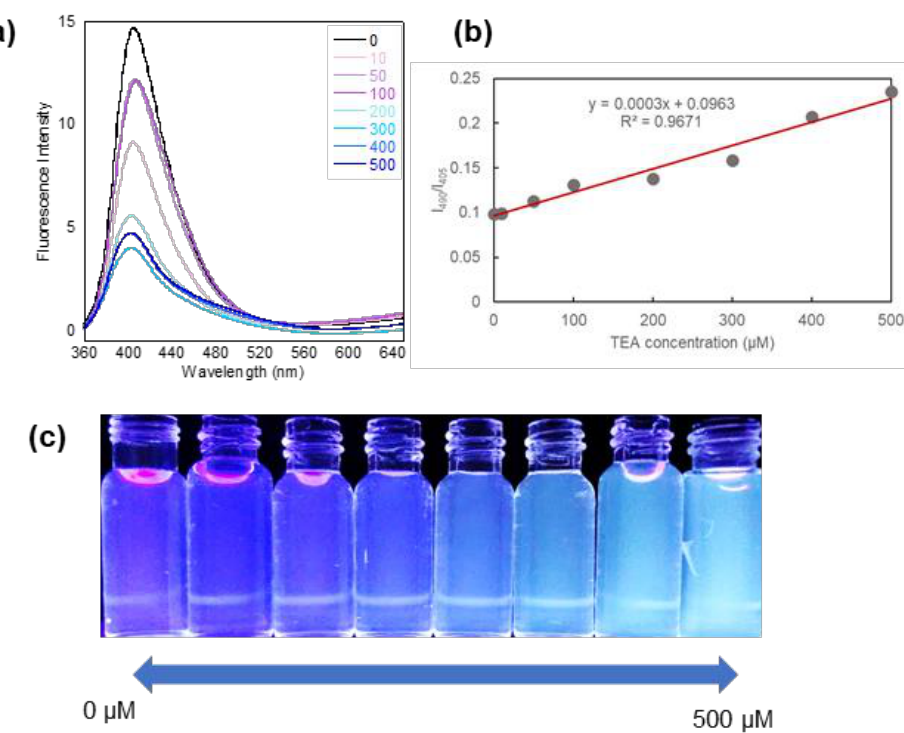
Figure 5. ( a ) Fluorescence spectra in H 2 O (conc. = 0.1 mg/mL, λ abs = 340 nm), ( b ) I 490 /I 405 plots, and ( c ) photographs of the aqueous solution of NP(Fl) after addition of TEA from 0 to 500 µ M. In the present system, the NP(Fl) aqueous solution emitted blue fluorescence, and the intensity at 402 nm decreased with the increasing PPD concentration (Figure 6), demon- strating that NP(Fl) acts as a simple turn-off sensor that shows fluorescence quenching after the addition of the target molecule. The addition of 10 µ M PPD led to a substantial decrease in the fluorescence intensity, suggesting efficient quenching. A visually detectable difference in the solution color was observed between the reddish-purple PPD solution and the blue NP(Fl)/PPD mixed solution, which became darker with an increase in the PPD concentration. Fluorescence quenching is caused by π – π interactions between Fl in the core of NP(Fl) and the aromatic portion of PPD, which may interfere with the aggregated state of the Fl unit in the cross-linked cores (Figure 3c). Note that a slight color change was an aromatic amine (PPD) was used, suggesting the potential of NP(Fl) for the